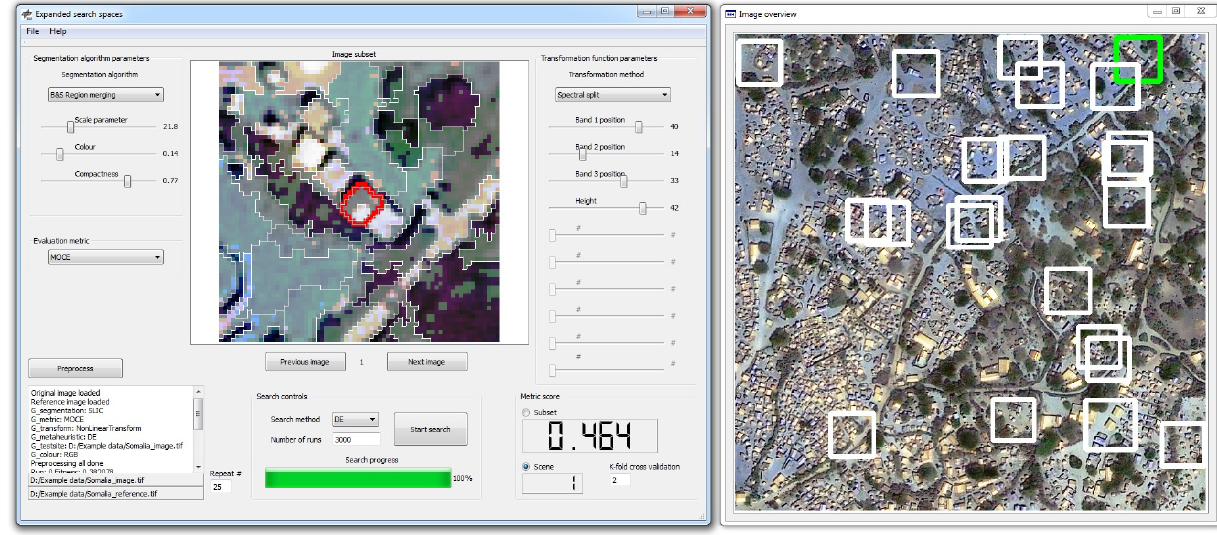
Figure 4. An example user interface for the search centric sample supervised segment generation approach described in this